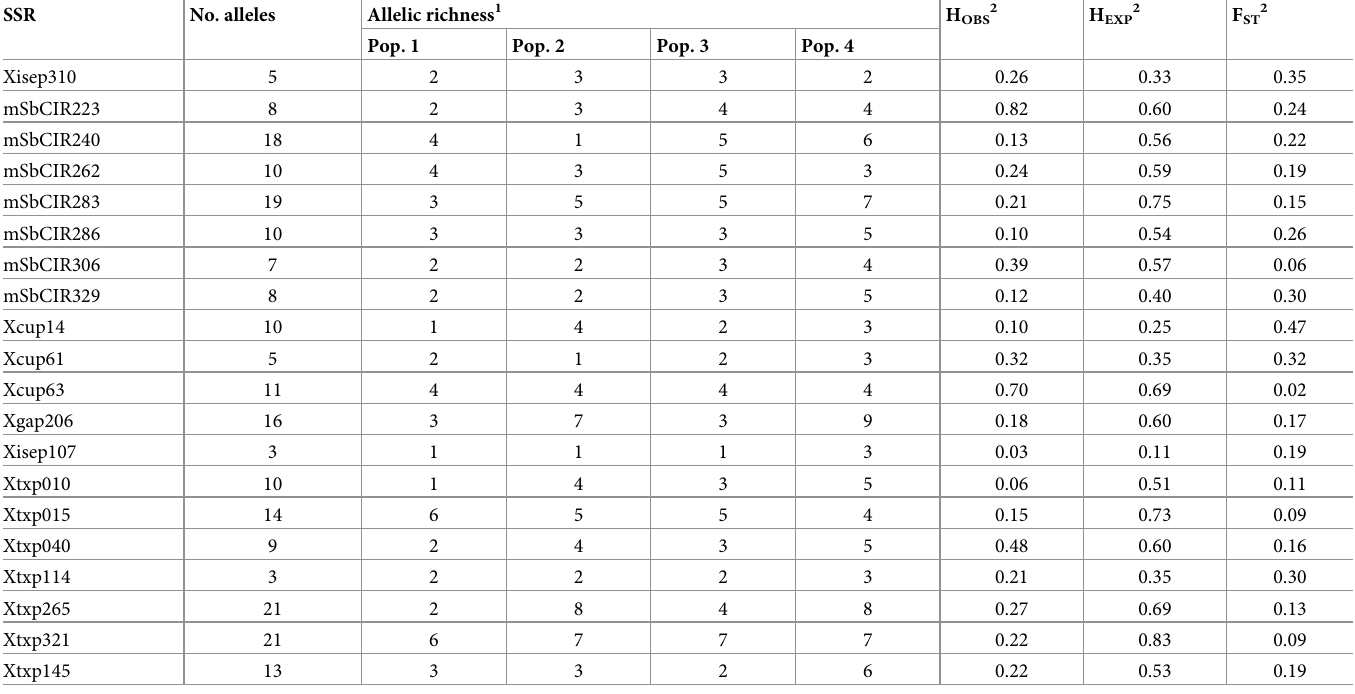
Table 2. Allelic diversity of NPGS Senegal sorghum germplasm